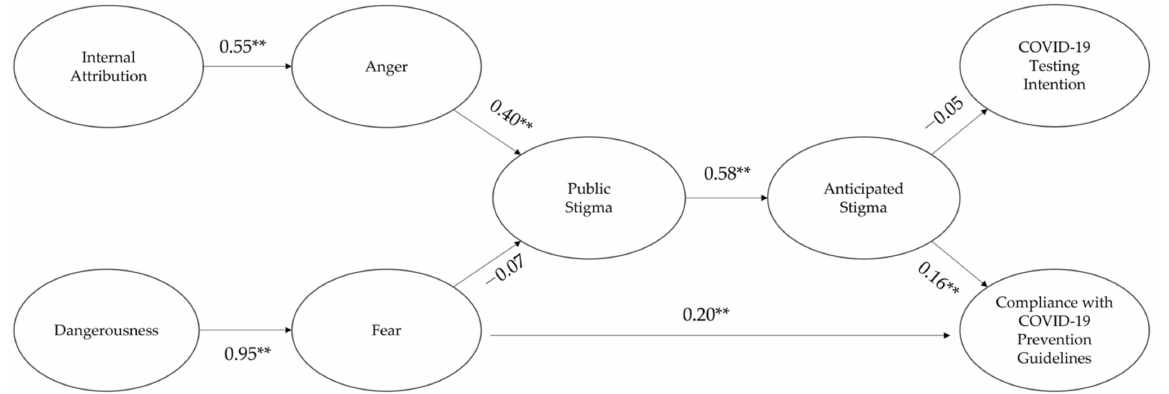
Figure 2. The standardized path coefficients for the conceptual model among participants in their 20s. ** p < 0.01. Table 3. The causal relationships between measures for participants in their 20s. Factors Path b Standardized b